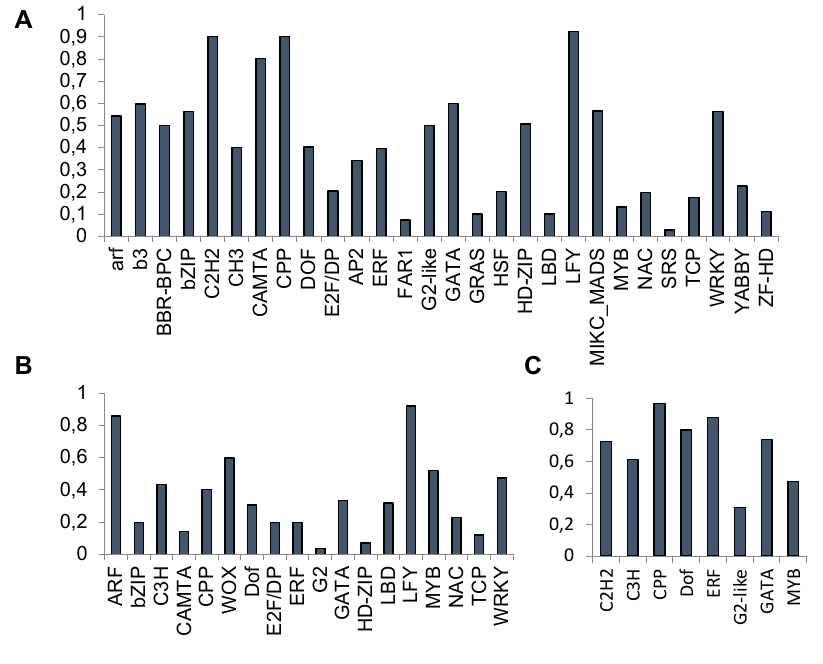
Figure 6: The occurrence of each transcription factor in the clusters (in the range [0;1]). A – Arabidopsis thaliana